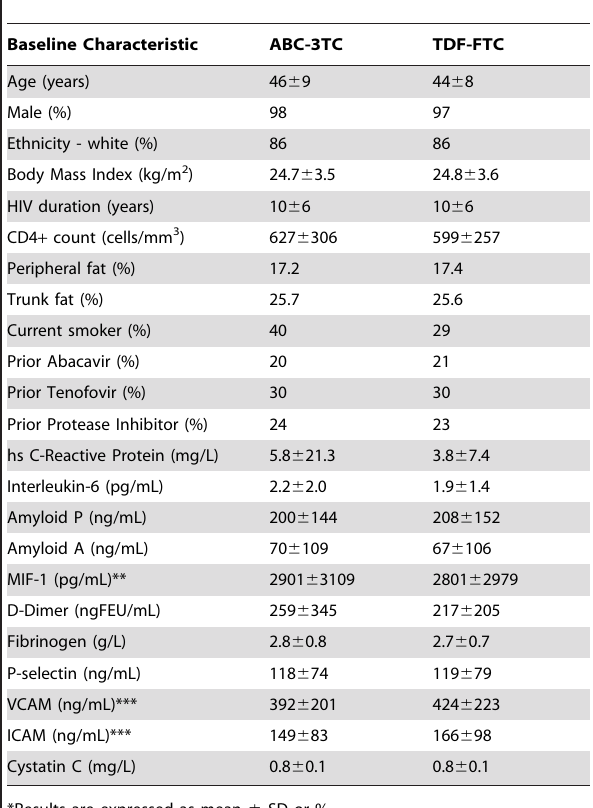
Table 1. Baseline characteristics for HIV participants randomised to ABC-3TC or TDF-FTC (n=357).